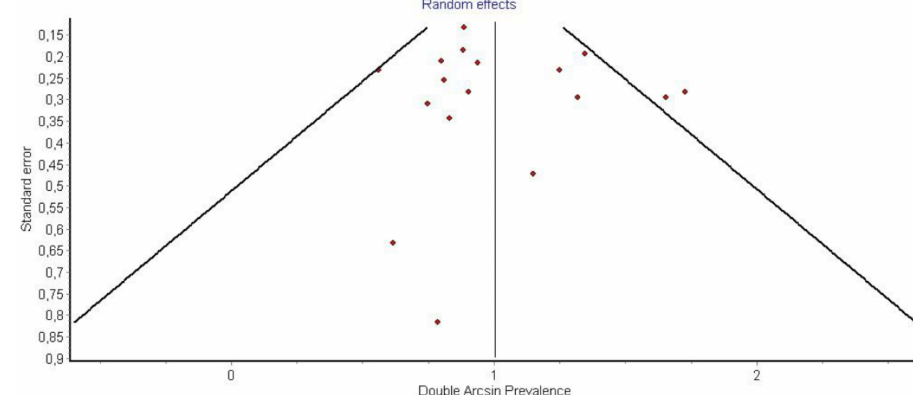
Figure 5. Funnel plot P2.